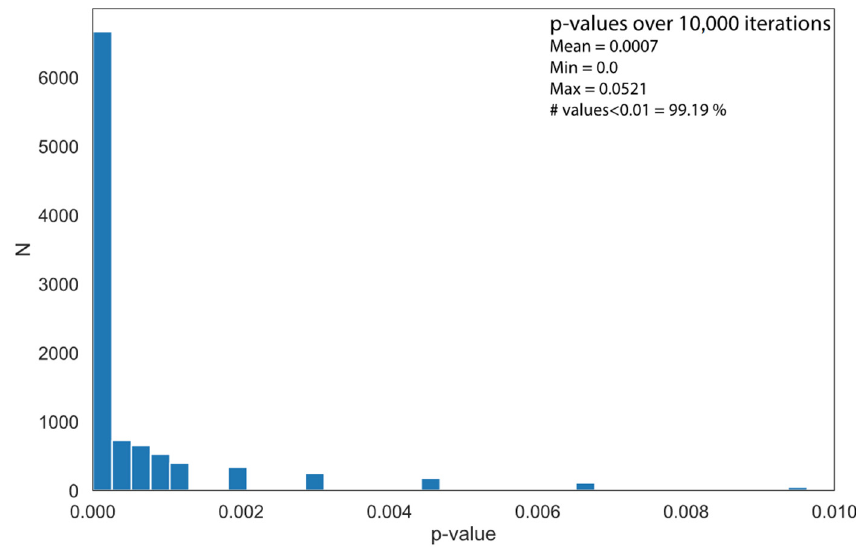
Figure 8. p -value test results over 10,000 random distributions.